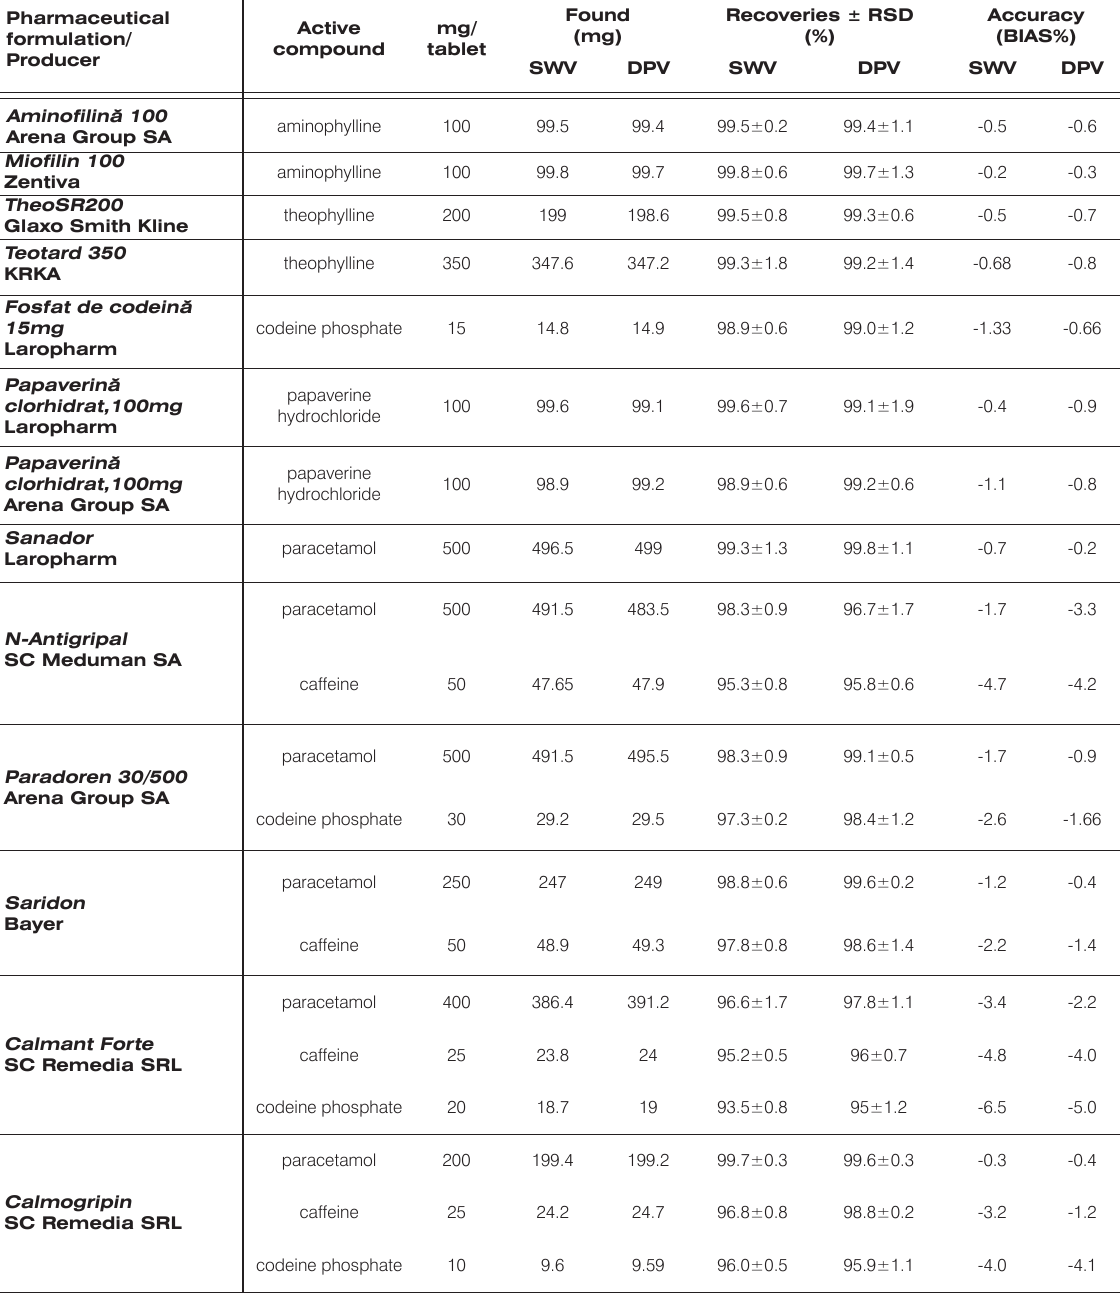
Table 3. Precision and accuracy obtained for pharmaceutical formulation (tablets and